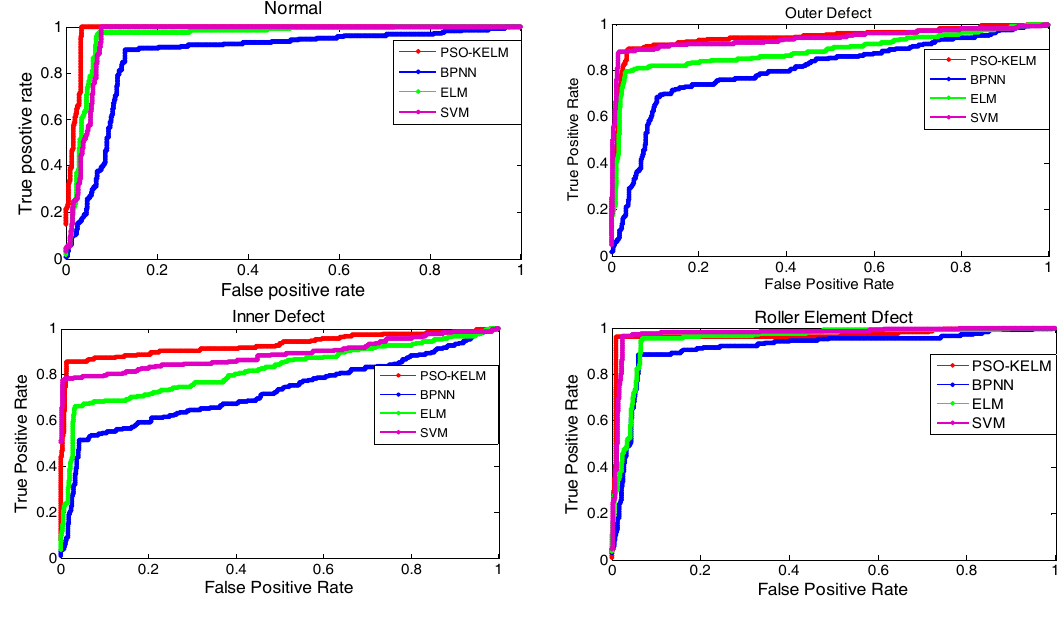
Figure 15. Receiver operating characteristic (ROC) curve of each classifier. Table 6. Area under the ROC curve (AUC) values of each classifier.